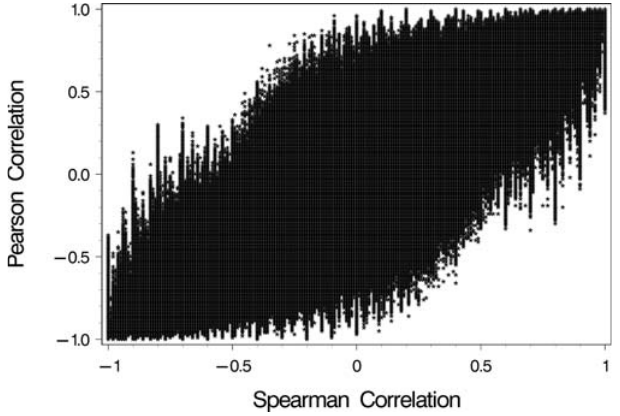
Figure 3. The Distributions of Correlations in Control and IR Are Highly Similar Control (blue dashed) and IR (red solid) lines overlay each other across the entire distribution. The vertical lines in each tail of the distribution delineate the edges that were included in the graph after applying the threshold of j 0.875 j to the correlation matrix. DOI: